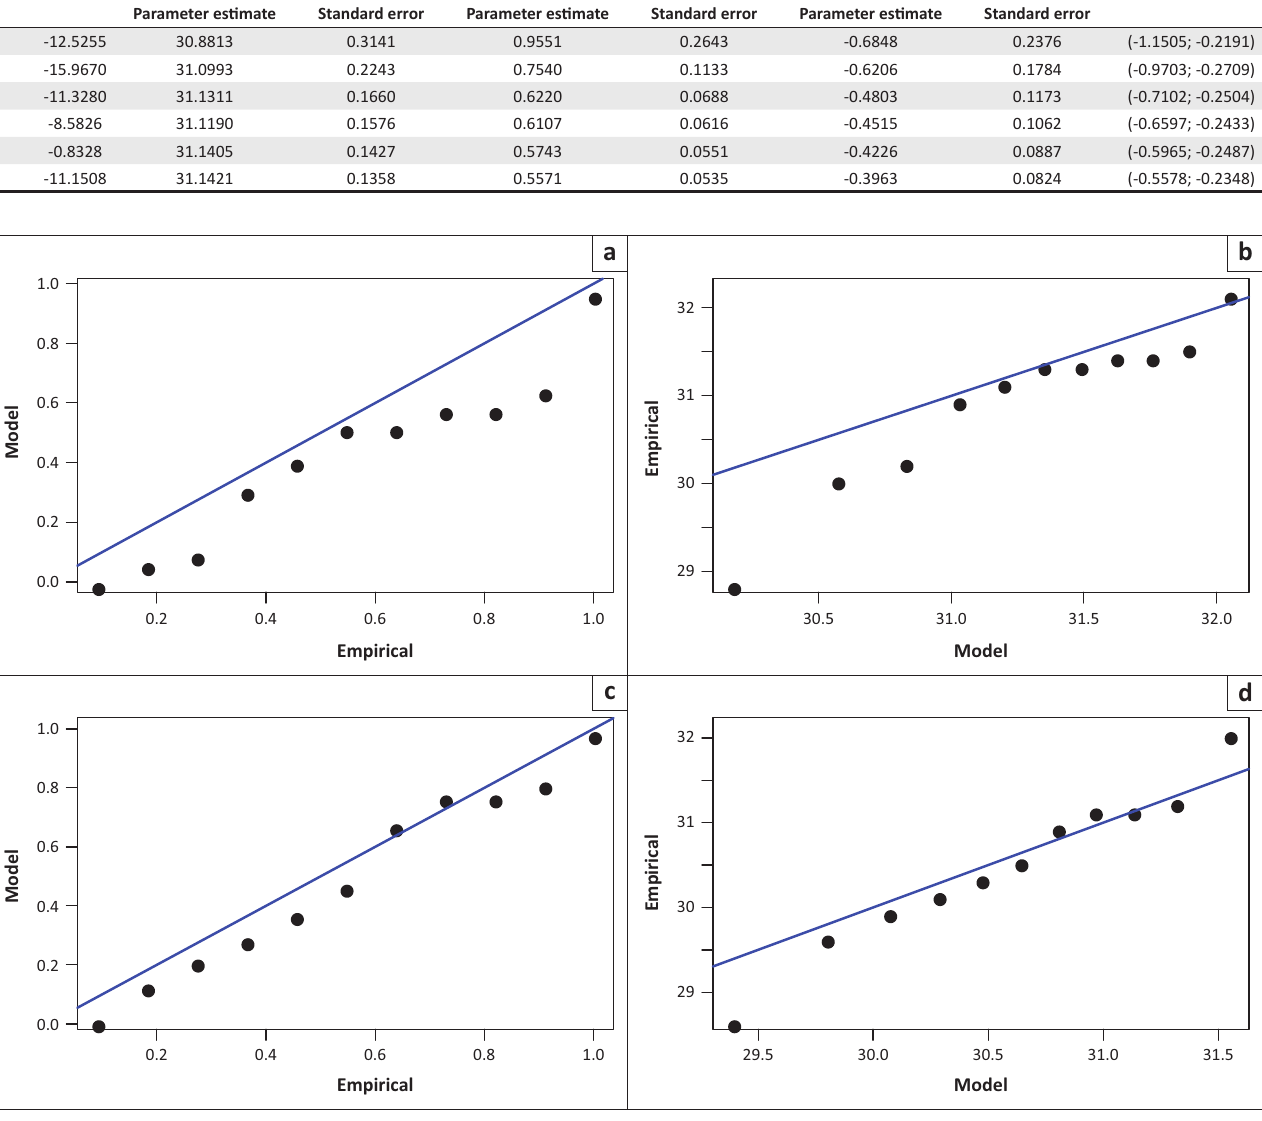
FIGURE 2: Diagnostic plots illustrating the fit of the data (annual average maximum temperature) to the generalised extreme value distribution for r largest order statistics model with k = 1 and k = 2, (a) probability–probability plot for k = 1, (b) quantile–quantile plot for k = 1, (c) probability–probability plot for k = 2, and (d) quantile–quantile plot for k =